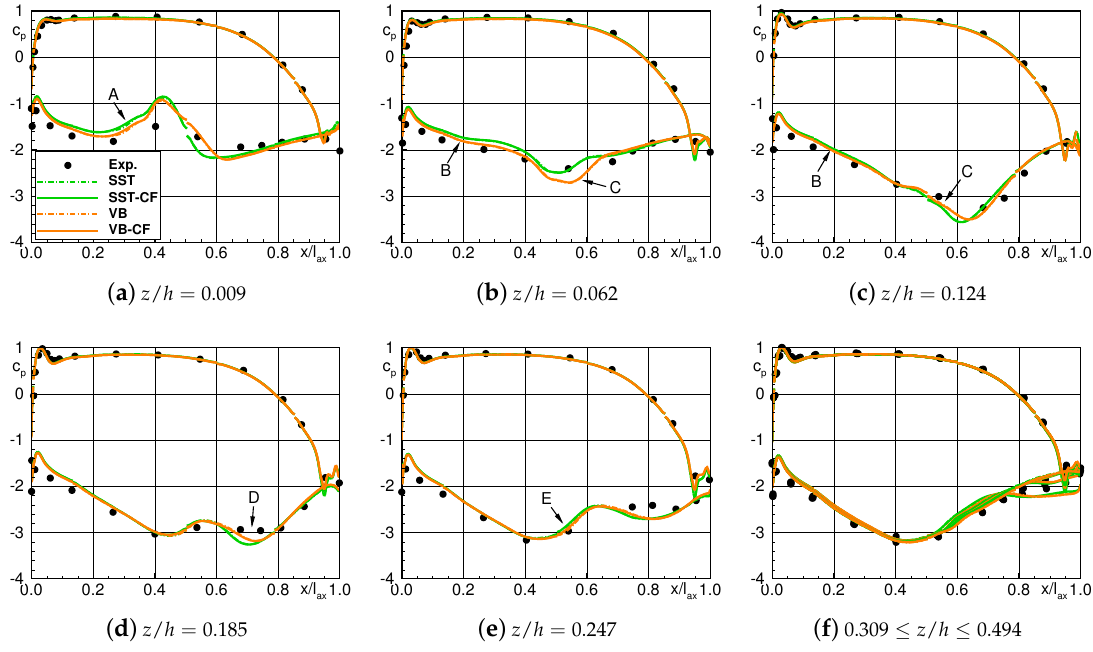
Figure 3. Comparison between experimental [19] and numerical results for surface pressure coefficient c p of the Langston